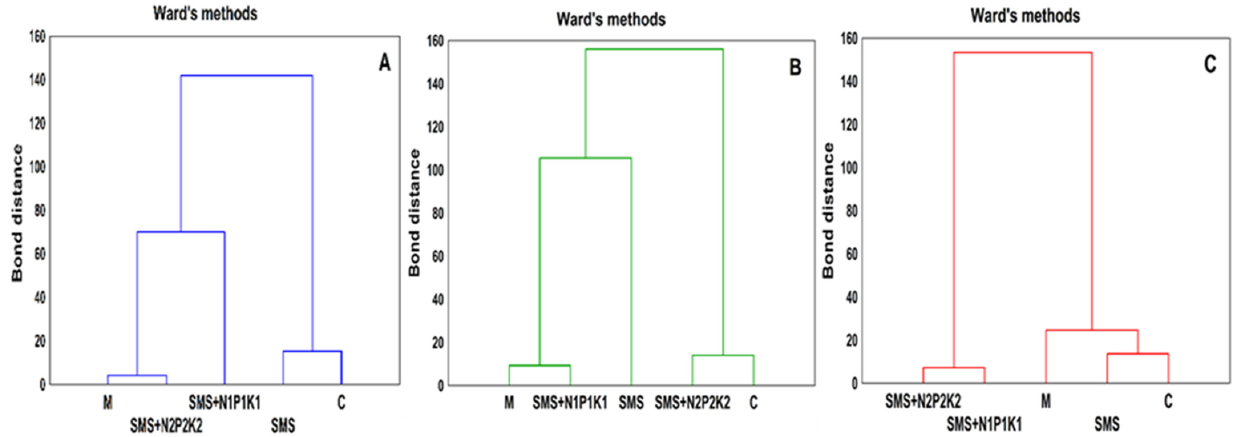
Figure 10. Tree diagram—Ward’s dendogram for ( A ) microbial counts; ( B ) enzymatic activity; and ( C ) biochemical activity. C—control soil; SMS—soil + spent mushroom substrate, SMS + N1P1K1—soil + spent mushroom substrate + mineral fertilization N1P1K1; SMS + N2P2K2—soil + spent mushroom substrate + mineral fertilization N2P2K2; M—soil + manure.